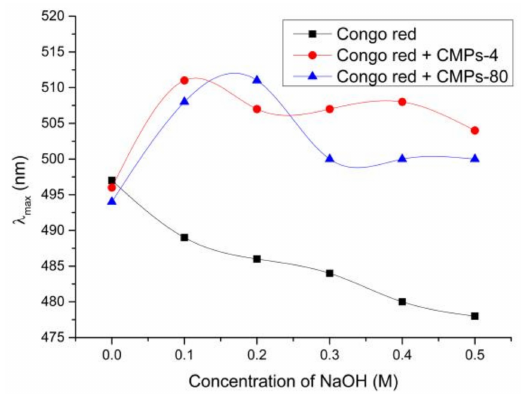
Figure 3. Conformational characteristics of CMPs-4 and